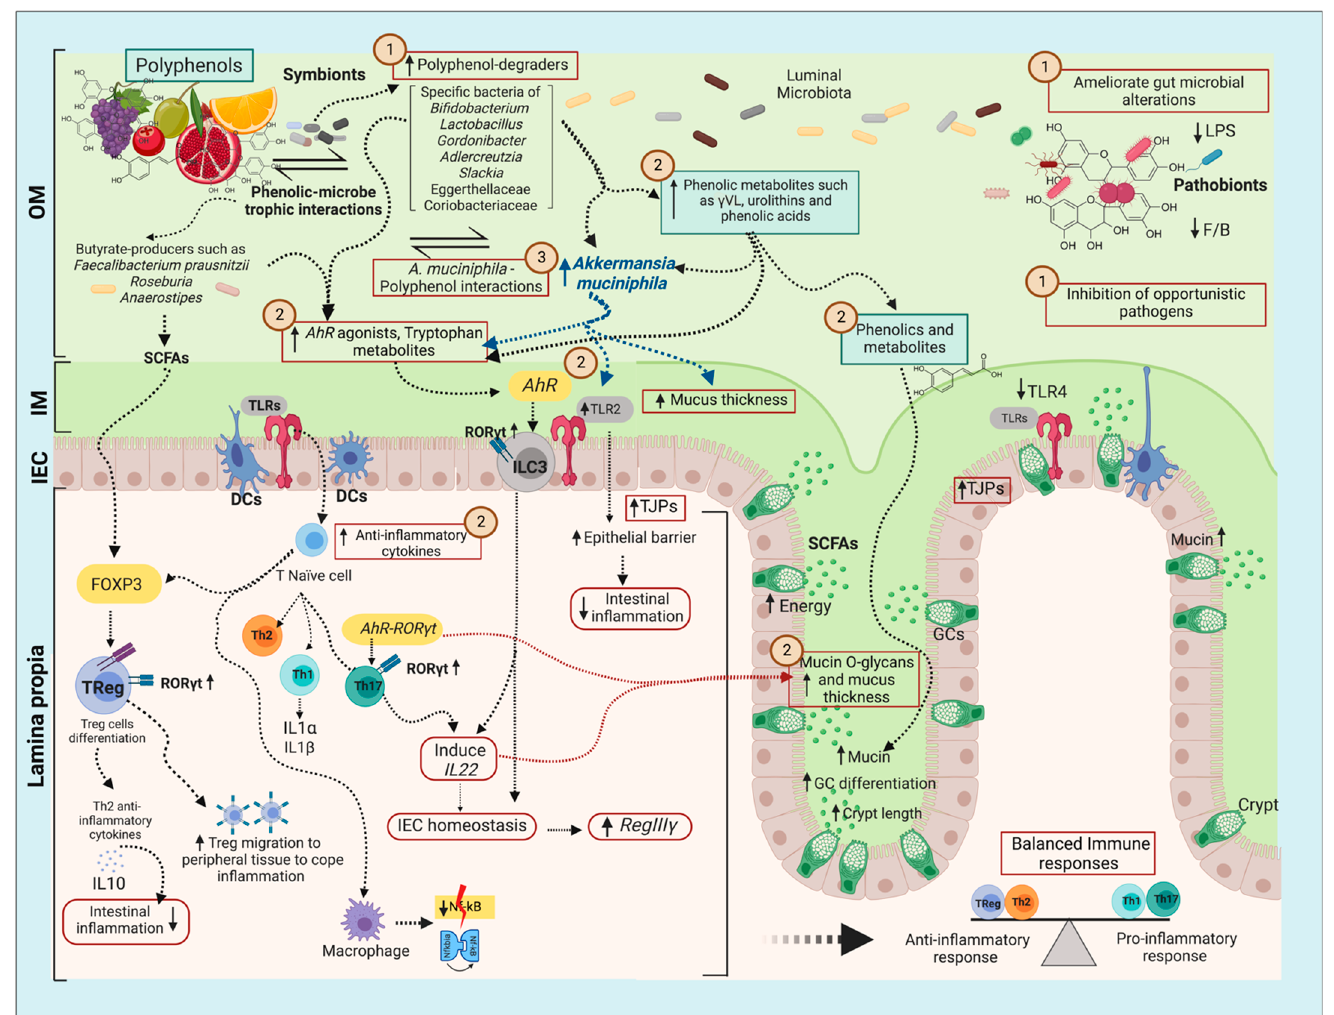
Figure 4. Pleiotropic polyphenol–microbiota interactions promoting an increase in Akkermansia muciniphila in the host gut. Metabolic diseases, such as obesity and type 2 diabetes, are associated with an altered intestinal ecological niche primarily associated with the onset of gut microbiota dysfunctions and a decrease in relative levels of A. muciniphila . The consumption of polyphenols, either pure or combined with other dietary susbstrates (e.g., fibers) shapes the gut microbiota composition, selectively promoting the relative abundance of A. muciniphila in association with improved metabolic outcomes in the host. Three main routes underline the stimulatory effects of polyphenols on A. muciniphila (represented by enumerate circles): ( 1 ) Interactions between polyphenols and the gut microbiota result in the inhibition of opportunistic pathogens, in addition to favoring symbiotics and the polyphenol-degrader microbes. Polyphenols reduce the level of lipopolysaccharides (LPS) and suppress the Toll-like receptor (TLR)-4, attenuating metabolic endotoxemia. Polyphenol-microbe trophic interactions yield phenolic metabolites, such as phenyl- γ -valerolactones ( γ VL), urolithins, and phenolic acids. De novo generated phenolics and the microbial metabolites trigger immunological pathways, restoring the gut epithelial function and homeostasis and positively affecting the abundance of A. muciniphila . ( 2 ) Notably, phenolics and tryptophan metabolites signal the Aryl hydrocarbon receptor ( AhR ). This activation controls cell recruitment, Th2 and Th17/IL-22 responses, and the remodeling of mucin O-glycans and intestinal epithelial cells (IEC) in an IL-22 dependent manner. AhR activation in lymphocytes also influences cells recruitment and IL-22 expression and improves intestinal inflammation. Then, the polyphenol-induced AhR/IL-22 pathway provides A. muciniphila with a restored microecological niche. Polyphenols and A. muciniphila jointly act as activators of AhR , playing regulatory roles in intestinal cell function. A. muciniphila colonization contributes to a reduction in proinflammatory markers via TLR2 induction, helping to cope with low-grade local inflammation and promote epithelial tight-junction proteins (TJPs). In addition, SCFAs, such as butyrate, can drive the activation of the transcriptional regulator Forkhead box